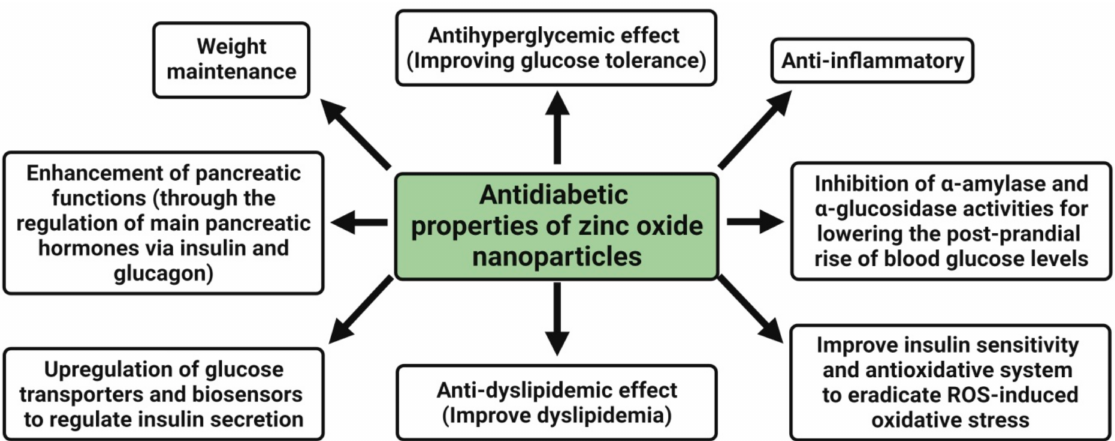
Figure 4. Possible antidiabetic mechanism of plant-mediated zinc oxide